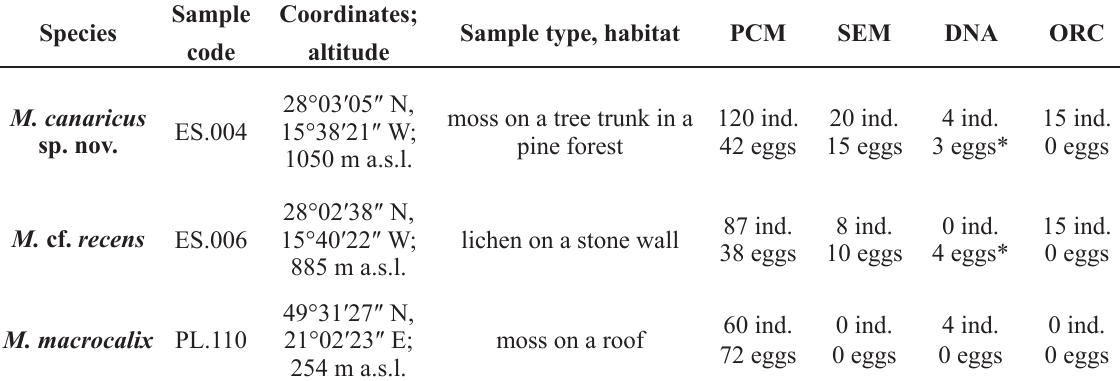
Table 1. Sample collection details and numbers of individuals and eggs used for integrative analyses of M. canaricus sp. nov. and M. cf. recens Cuénot, 1932. (PCM = phase contrast microscopy; SEM = scanning electron microscopy; DNA = DNA sequencing; ORC = orcein staining) *Eggs were taken from the culture and incubated individually until hatching, then the juveniles were used for DNA sequencing whereas egg chorions (isogenophores) were mounted on microscope slides in Hoyer’s